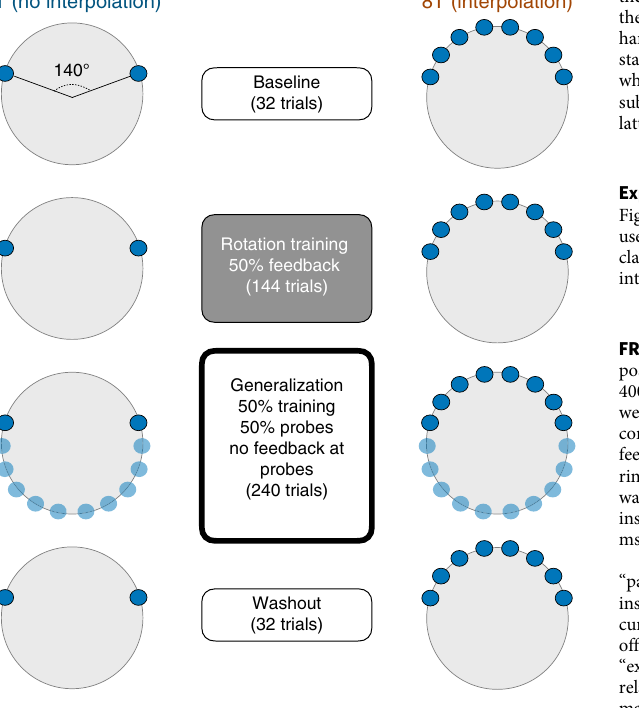
Fig. 9 Experiment 4 design. Subjects learned to counter a 45 ˚ rotation in either a 2T learning condition (left) or an 8T learning condition (right). In